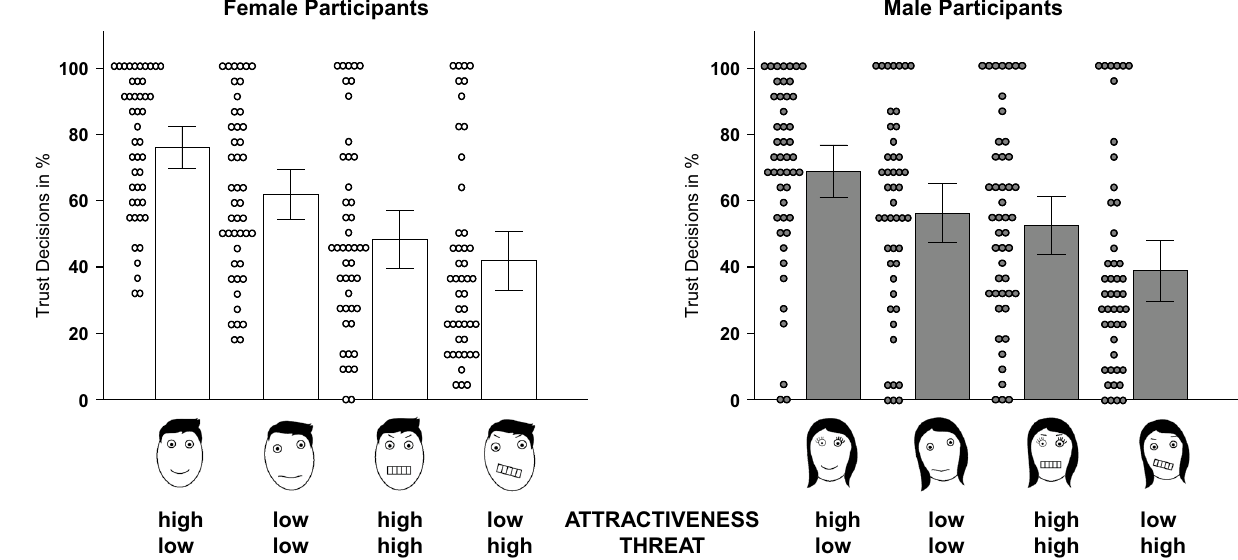
Figure 1. Effects of attractiveness and threat on trust behavior. Phenotypes from left to right are: ‘high attractiveness and low threat’, ‘low attractiveness and low threat’, ‘high attractiveness and high threat’, ‘low attractiveness and high threat’. Left: Trust decisions in percent for female participants. All differences are statistically significant (all p < 0.011). Right: Trust decisions in percent for male participants. All differences are statistically significant (all p < 0.001), except for the difference between the faces of the phenotypes ‘low attractiveness and low threat’ and ‘high attractiveness and high threat’. Please note that the symbolic faces in this figure represent schematic representations of the actual stimuli that were derived from photos of real human faces (for details, see Fig. 2). Bars represent standard errors; dots represent the mean trust decision in percent for each participant and each phenotype. For mean values and standard deviations of trust decisions, rating values and response times, see Tables S2–S4, respectively, in the Supplementary